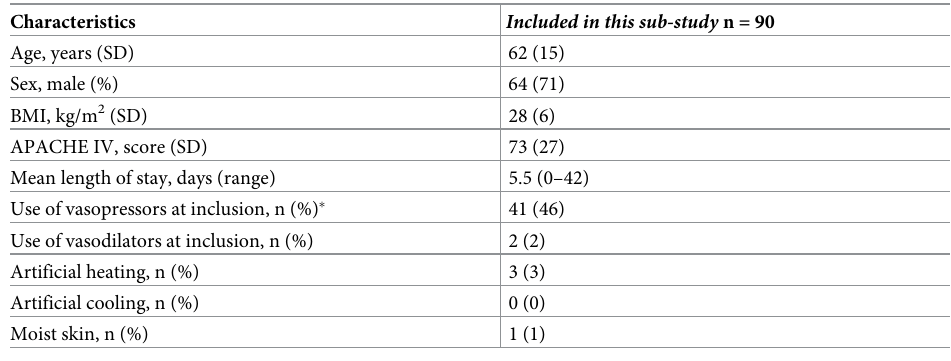
Table 1. Baseline patient